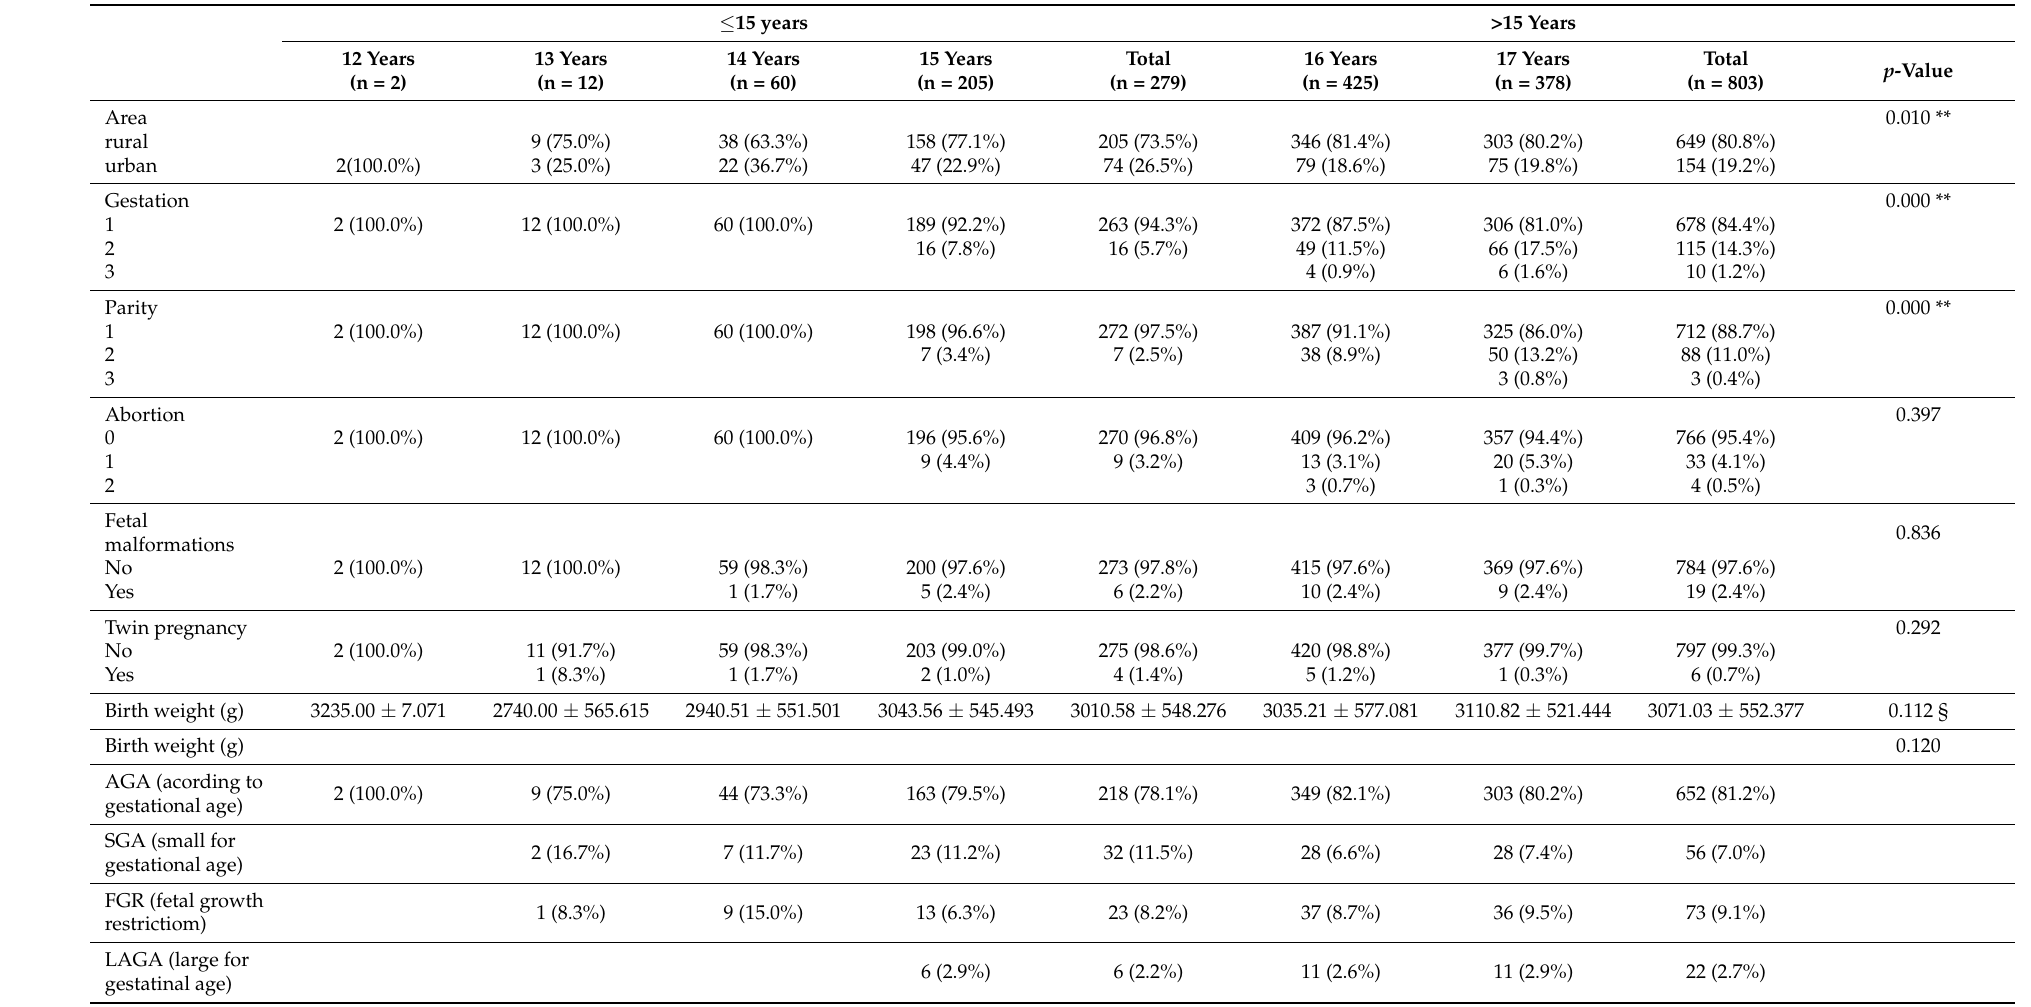
Table 1. Characteristics of pregnant teenagers in our study population (part